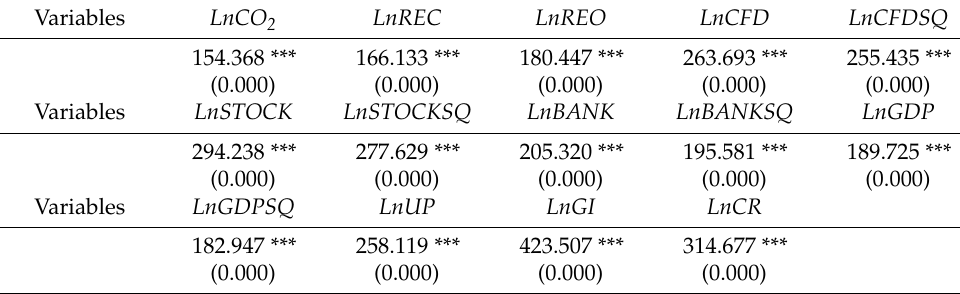
Table A1. Results of Fisher’s augmented Dickey–Fuller unit root test.